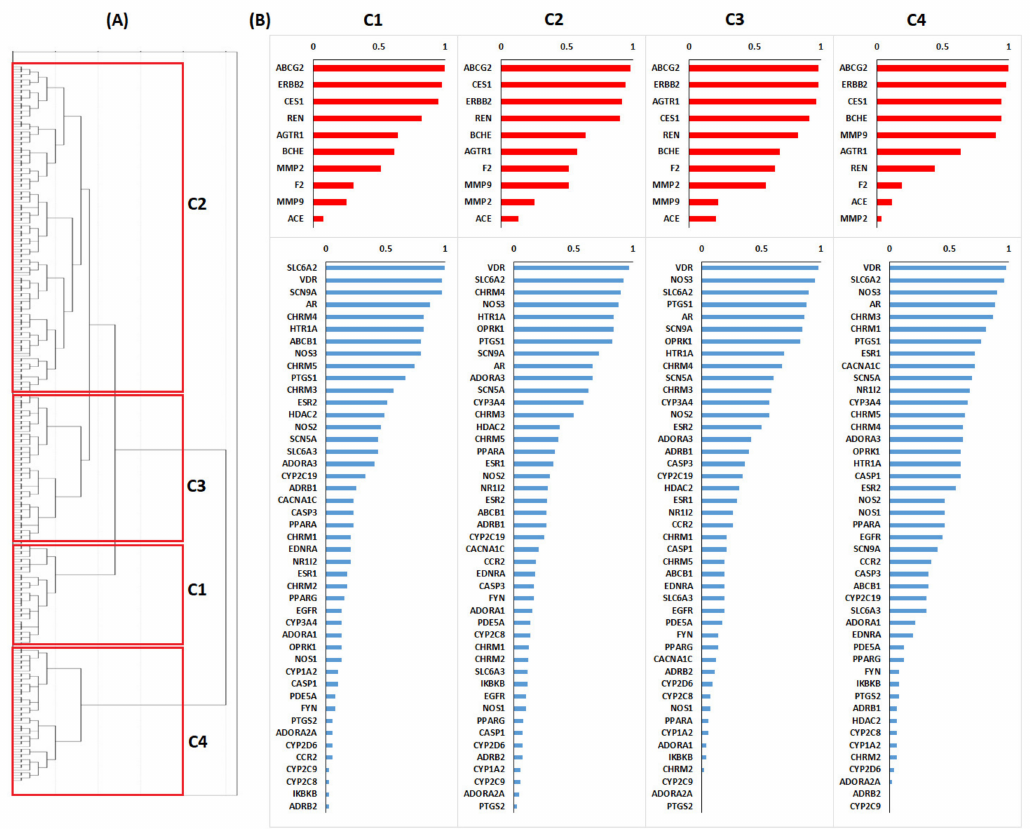
Figure 3. ( A ) Dendrogram obtained from all virtual screening performance models with BEDROC > 0.15. ( B ) Clusters are labeled as C1 to C4 . The relevance (S i ) of the Targets (blue) and Off-Targets (red) was computed for each